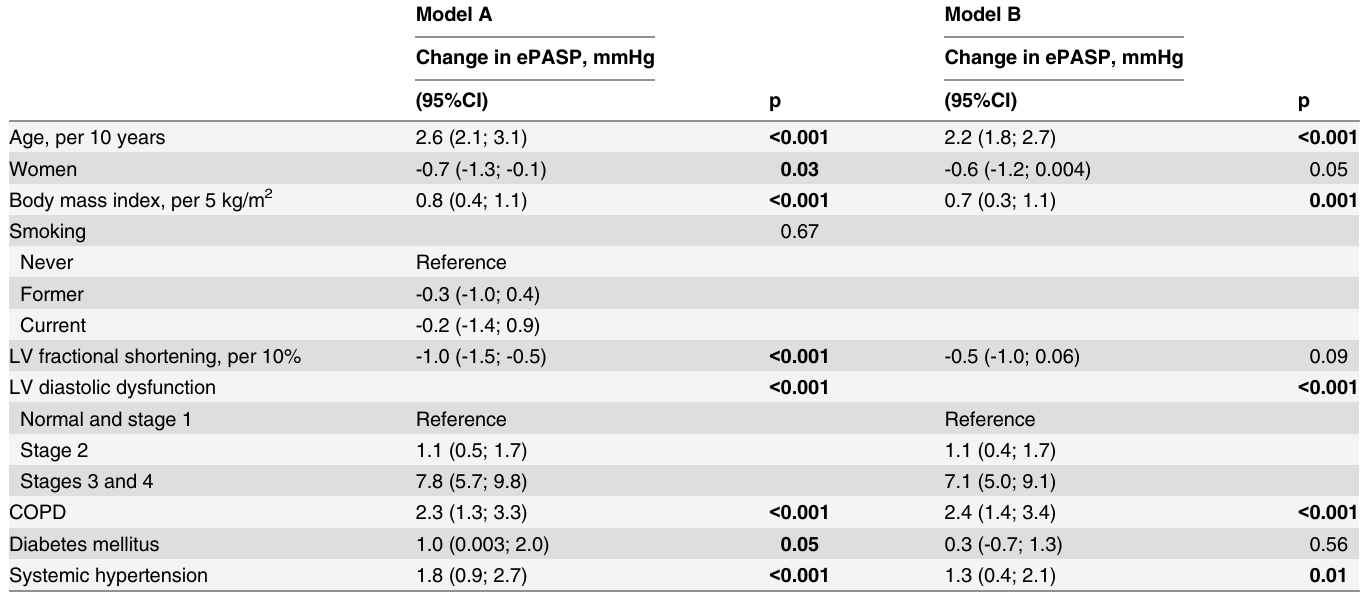
Table 4. Associations with pulmonary artery systolic pressure in linear regression models in 1945 participants in whom ePASP could be estimated. Model A Model